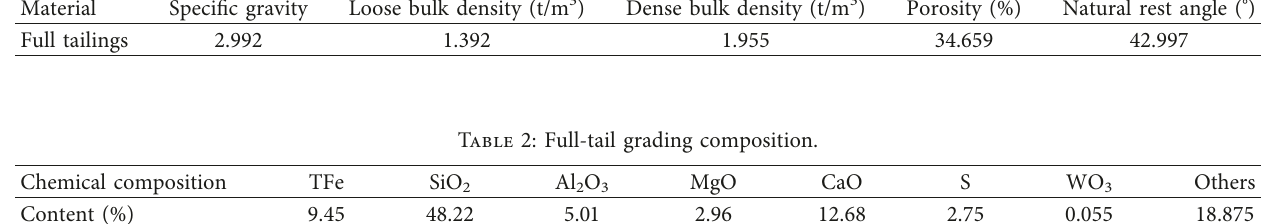
Table 1: Test of specific gravity, loose bulk density, dense bulk density, porosity, and natural rest angle. Material